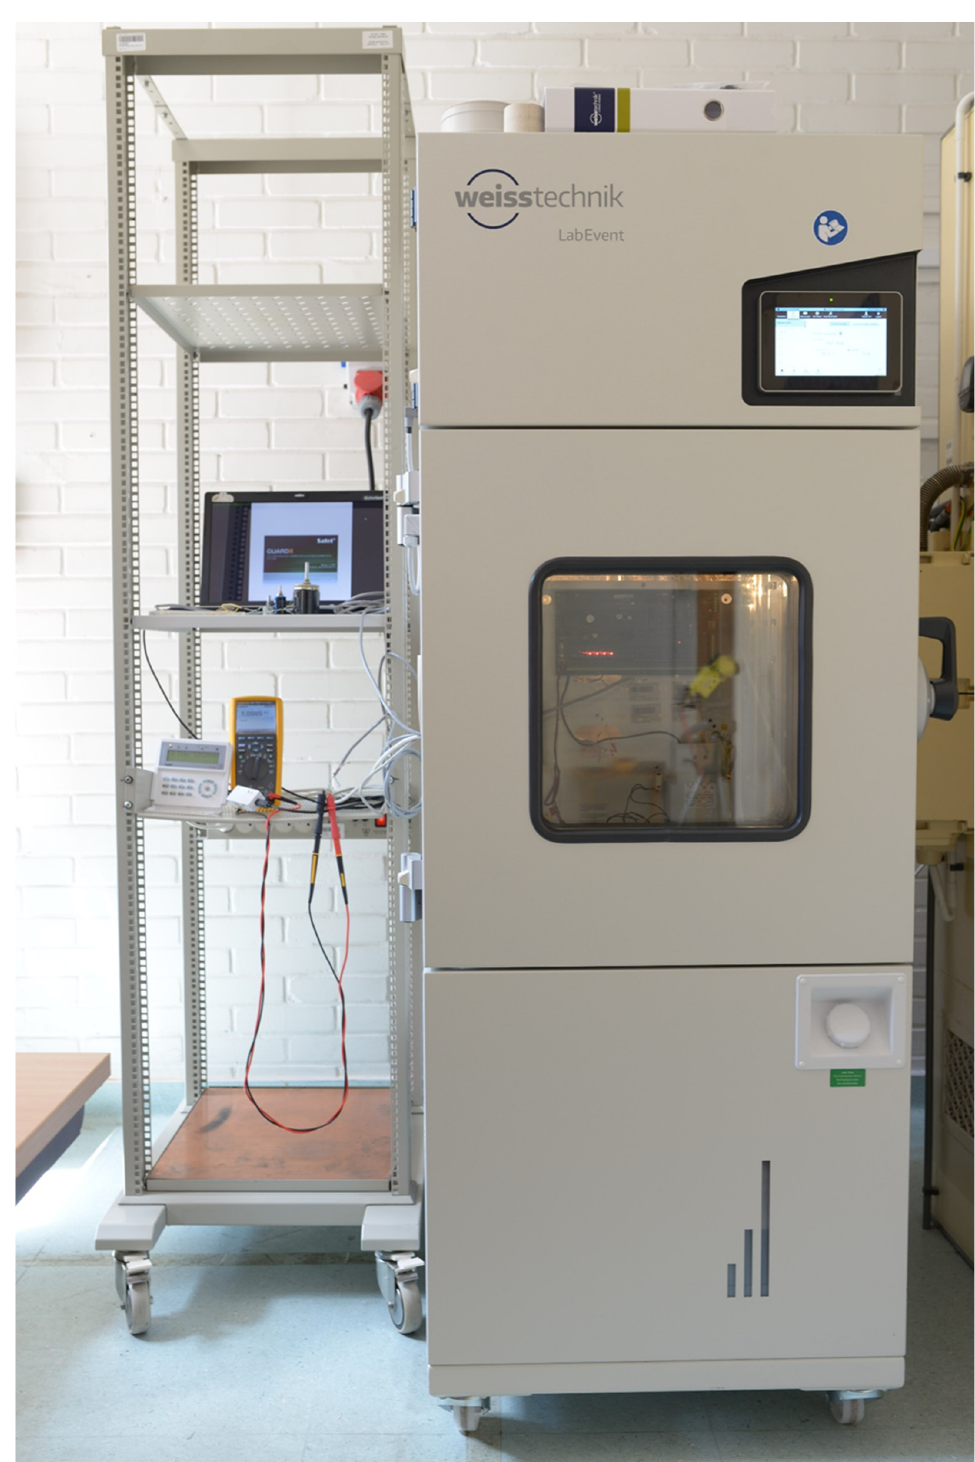
Figure 3. Test bench for studying the impact of temperature on the tripping thresholds of intrusion detection system detection circuits.